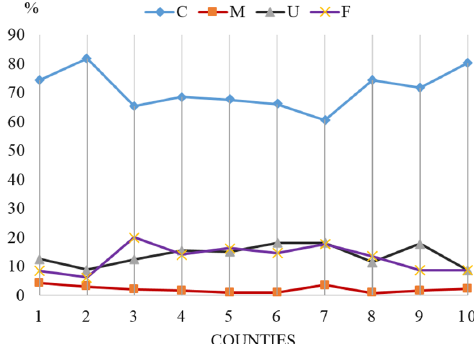
Figure A2. Rule-based rationality evaluation results. C, M, U, F stand for “Consistent”, “Misclassified”, “Uncertain”, and “Fuzzy”, respectively. The ten counties are: Huachuan = 1, Jixian = 2, Shuangyashan City = 3, Huanan = 4, Yilan = 5, Boli = 6, Qitaihe City = 7, Fangzheng = 8, Suibin = 9, and Youyi = 10.